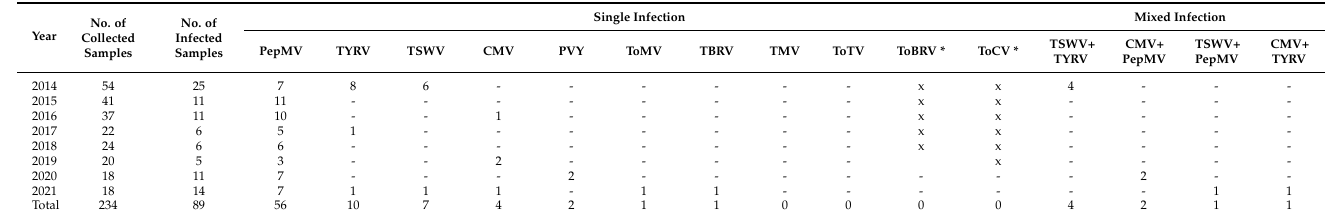
Table 3. Tomato samples tested by RT-PCR for 11 virus species grouped by